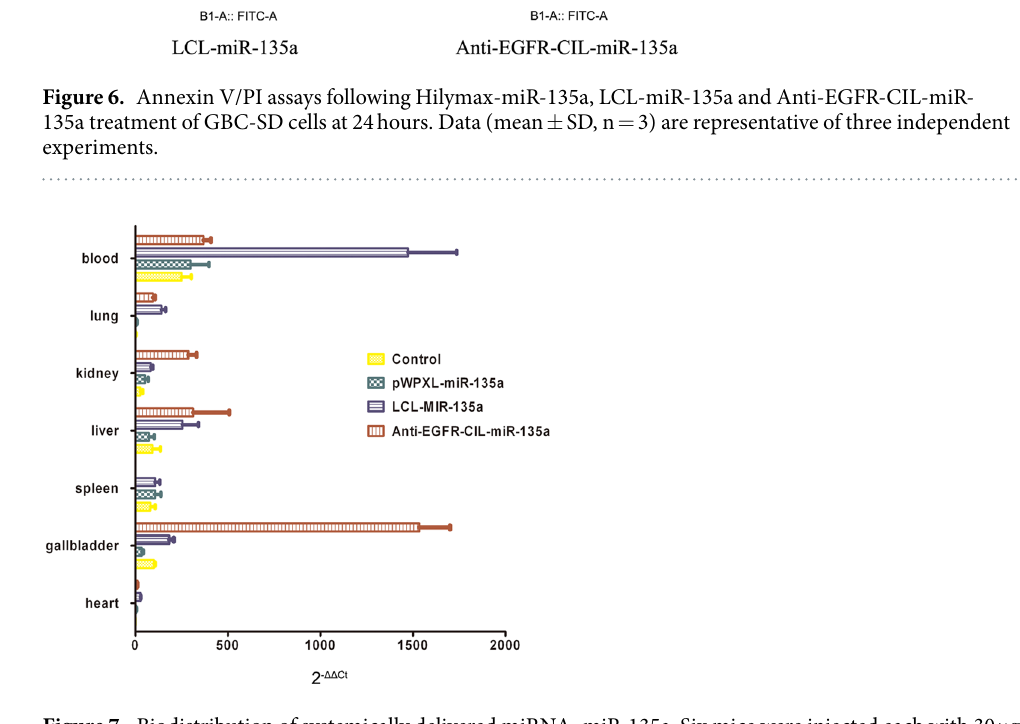
Figure 7. Biodistribution of systemically delivered miRNA- miR-135a. Six mice were injected each with 30 μ g of naked miR-135a, LCL-miR-135a, or Anti-EGFR-CIL-miR-135a. After killing at 12 hours post injection, total RNA was isolated from whole blood, liver, kidney, spleen, lung, heart and